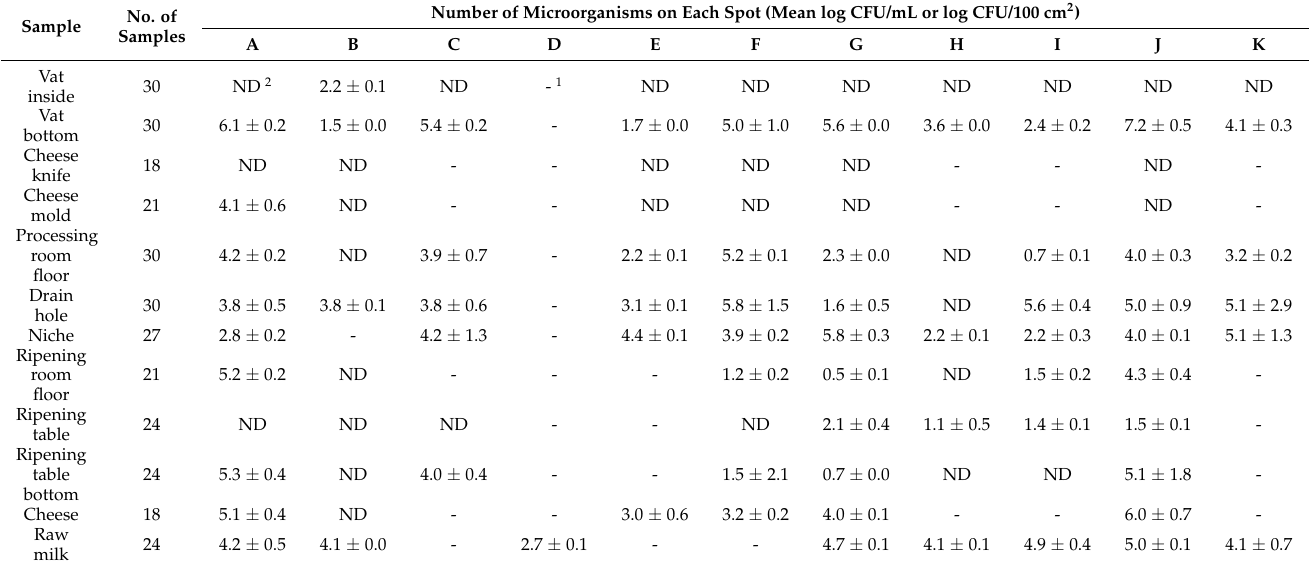
Table 5. Mean ( ± SD) psychrotrophic bacteria counts in the processing plants of each dairy farm (A to K). Sample No. of